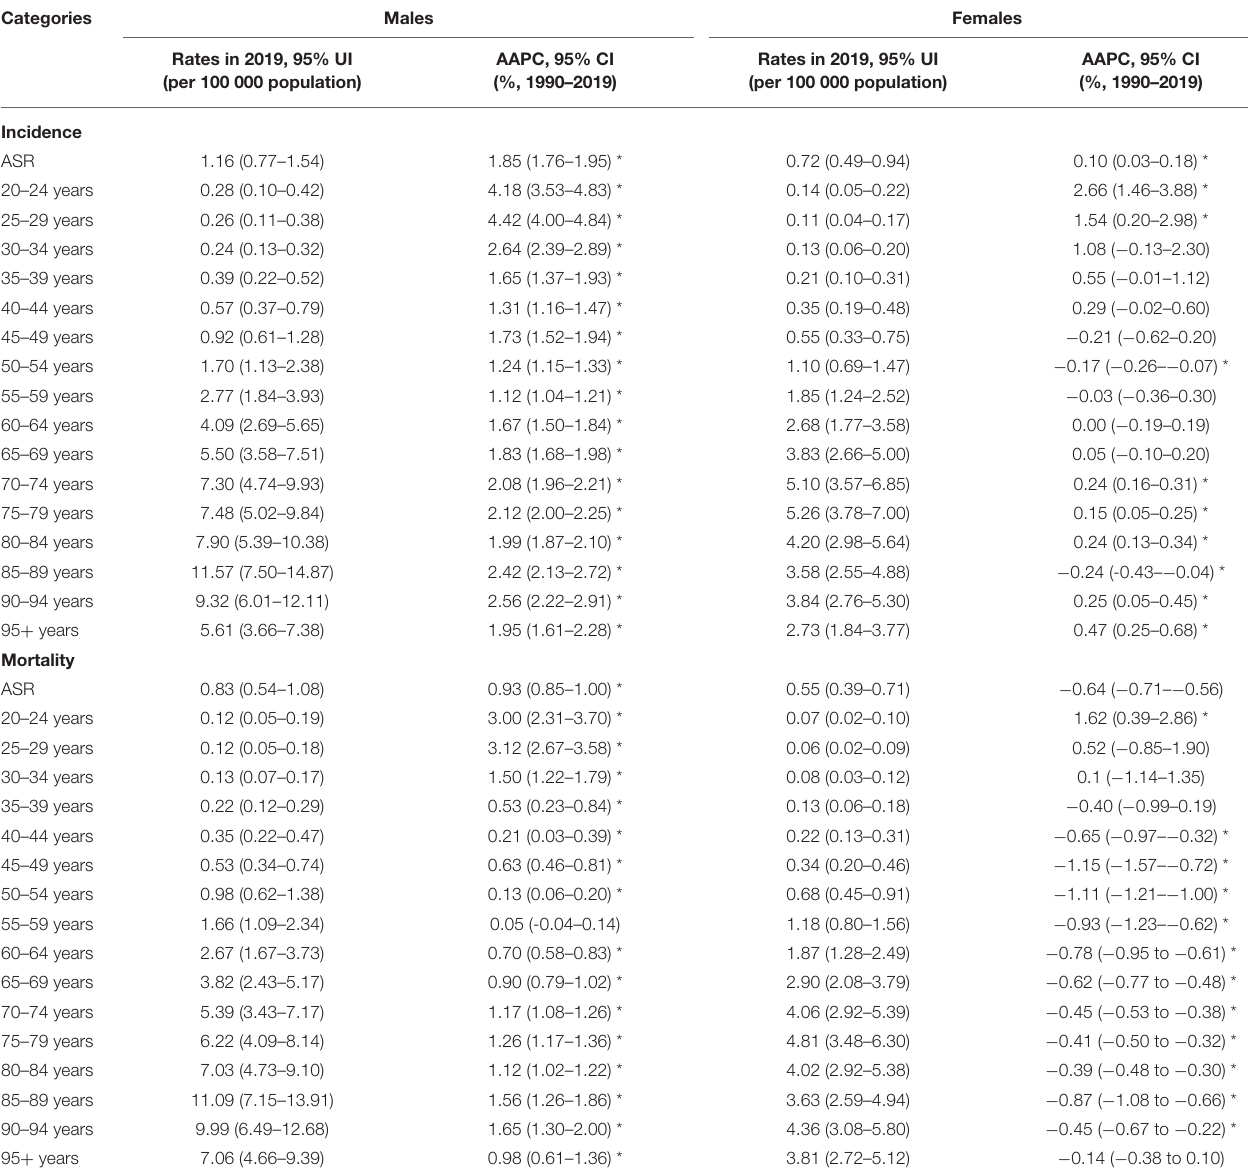
TABLE 1 | The sex-age-specific rates of MM in China in 2019 and their percentage changes from 1990 to 2019. Categories